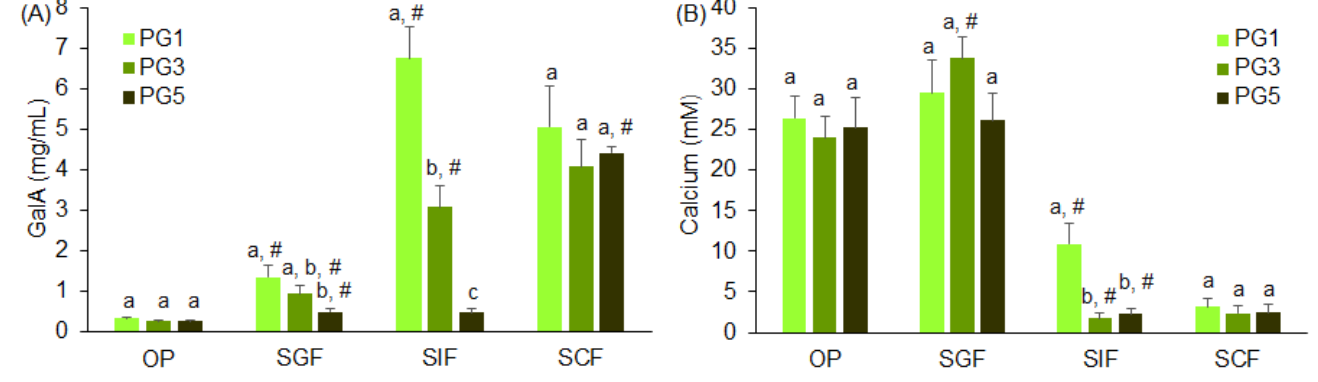
Figure 7. The amounts of galacturonic acid (GalA) ( A ) and calcium ( B ) released from PGs during successive oral in vivo (OP) and gastrointestinal in vitro phases of digestion. SGF, SIF, and SCF— simulated gastric, intestinal, and colonic fluids, respectively. Means with standard deviations are given. Differences are significant ( p < 0.05) between means labeled with different lowercase letters (a, b, and c); #—indicates significant differences vs. the previous phase ( n = 6, p < 0.05). The release of calcium during in vivo chewing could be attributed to the release of free calcium contained in the gel matrix rather than crosslinked calcium. The concentration of crosslinked calcium for PG preparation was excessive and corresponded to a stoichio- metric ratio (R = 2(Ca 2+ )/(COO − )) in the range of 4.1–5.7. The strongest gel was